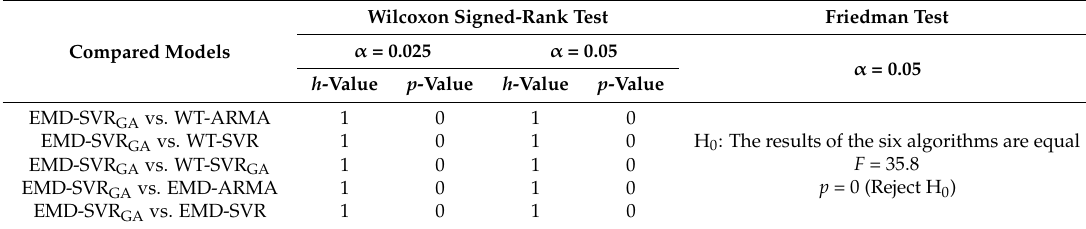
Table 6. Results of Wilcoxon signed-rank test and Friedman